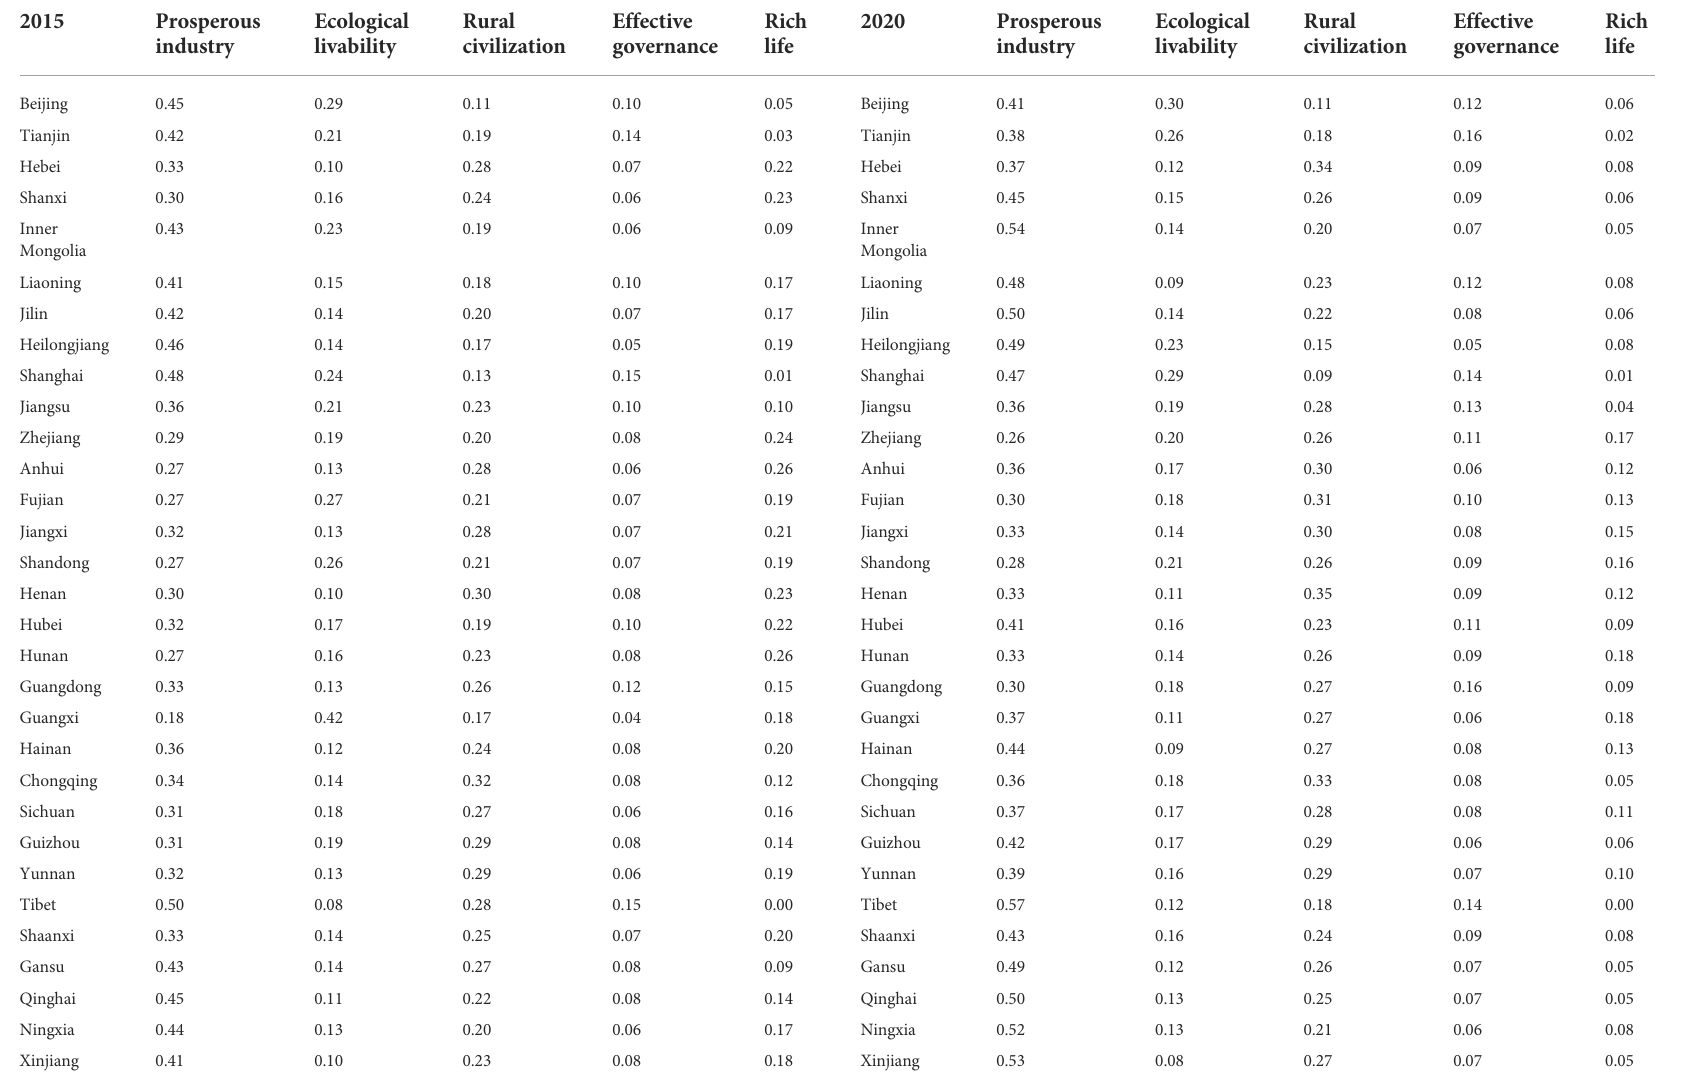
TABLE 8 Calculation results of each dimension proportion of 31PLAD in 2015 and